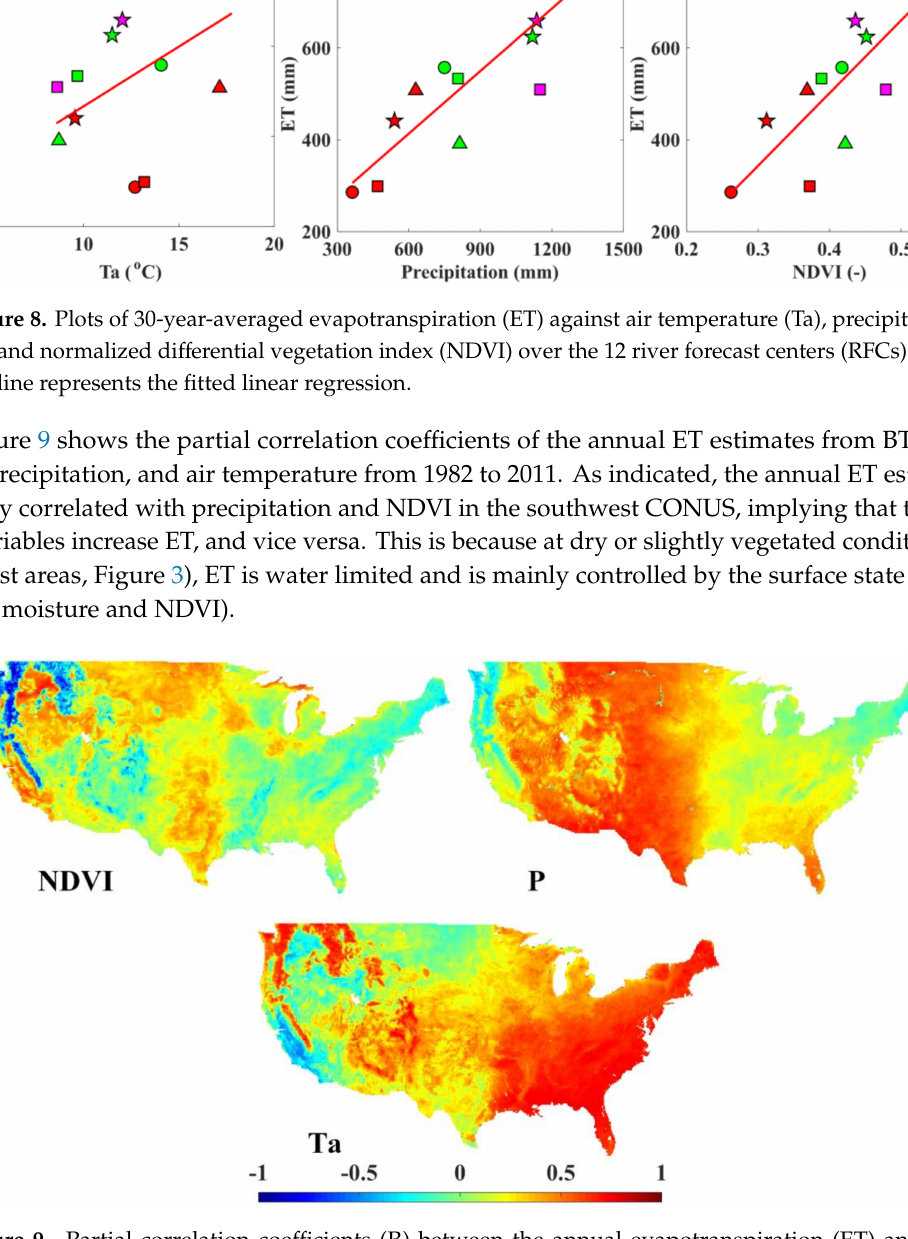
Figure 9. Partial correlation coe ffi cients (R) between the annual evapotranspiration (ET) and air temperature (Ta), precipitation ( P ), and normalized di ff erential vegetation index